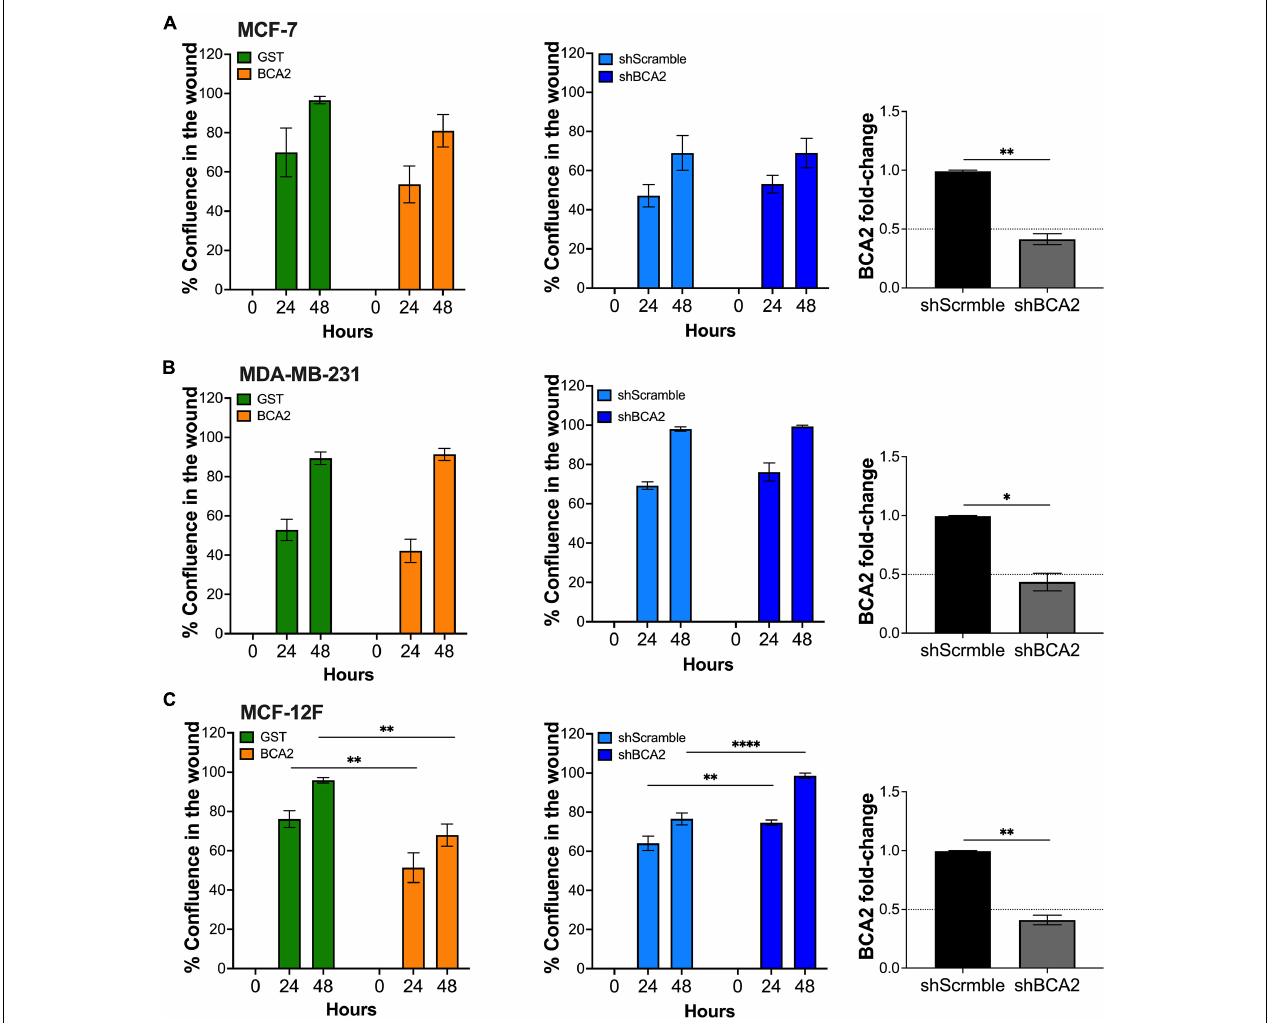
FIGURE 3 | BCA2 reduces cell migration in non-tumor epithelial breast cells. Cells, including MCF-7 cells (A) , MDA-MB-231 (B) and MCF-12F (C) were transfected with constructs encoding for HA-BCA2 or HA-GST as an irrelevant protein control. When cells reached confluence, a scratch was performed on the monolayer. Cell migration and confluence was measured by live cell imaging for 48 h. Similar assays were performed in cells stably depleted of BCA2 or carrying a scrambled shRNA (middle panels). BCA2 knockdown was verified on the day the cells were plated by RT-qPCR (right panels). Dotted lines represent threshold for biological significance. Data correspond to the mean and SEM of three independent experiments. * p < 0.05, ** p < 0.01, **** p <